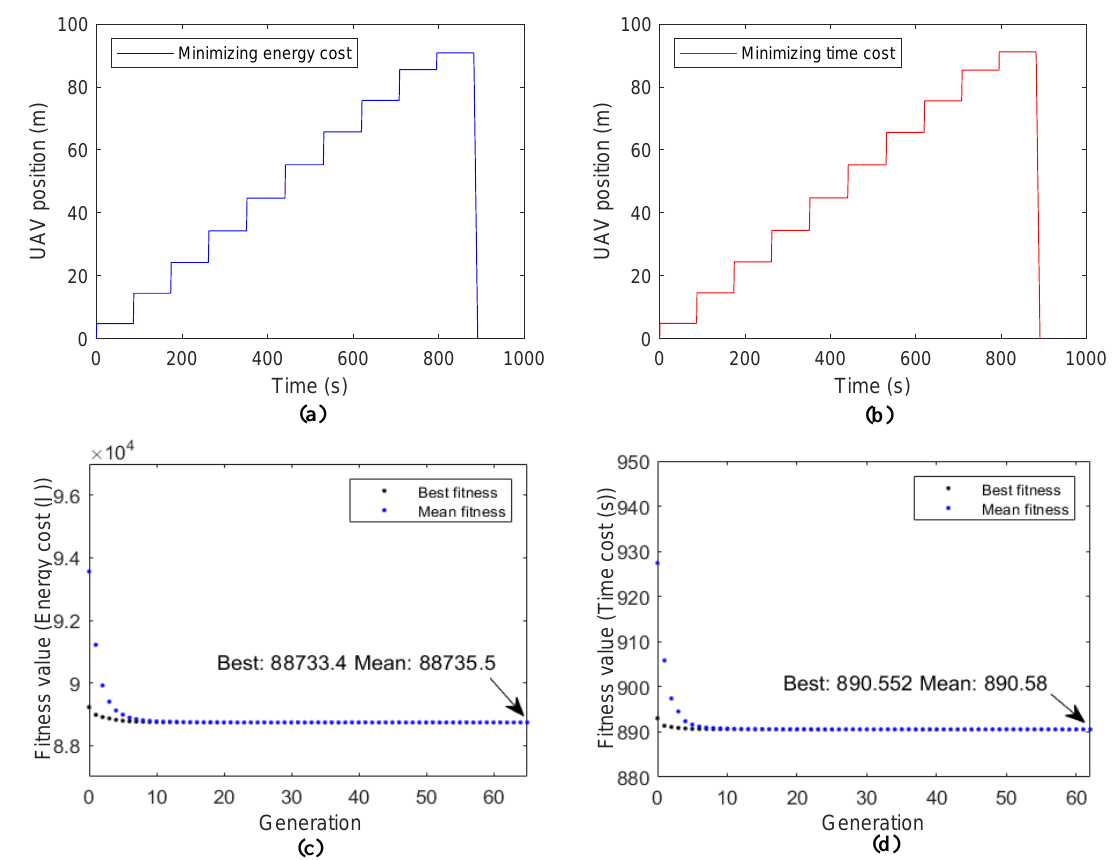
Figure 11. Simulation results of Scene IV : ( a ) UAV position at different times when minimizing the energy cost, ( b ) UAV position at different times when minimizing the time cost, ( c ) fitness value of the energy cost at different generations, and ( d ) fitness value of the time cost at different